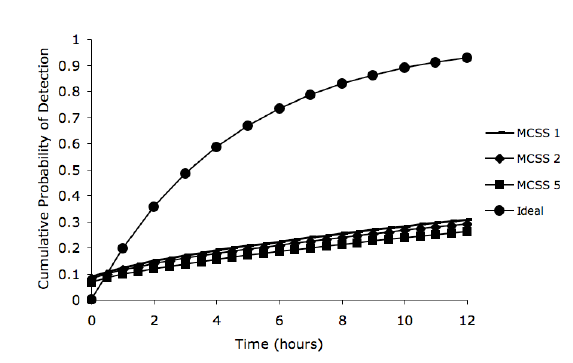
Fig.11. Average CPD of Initial USDEA Mesh Fields Communications Range = 5.5 kyd